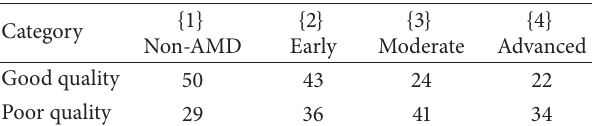
Table 1: Number of images in each AREDS category and for each image quality